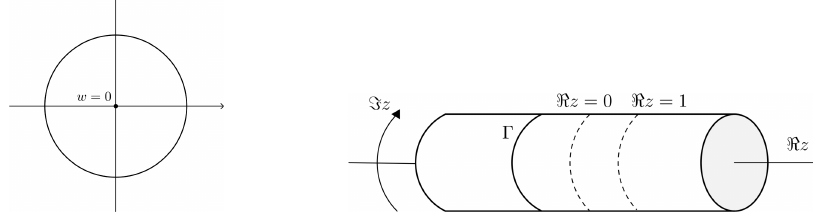
Figure 3 . Left: integration cycle in the w -plane. Right: the exponential map sends C to a cover of the cylinder, and the circle around w = 0 to a circle Γ wrapping the cylinder